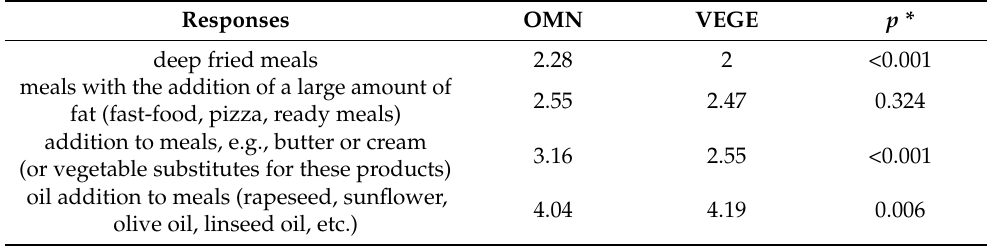
Table 8. Summary of the health state of the studied groups. Health State of the Studied Groups With risk factors for cardiovascular diseases (smoking regularly and/or medium/high alcohol consumption) With risk factors for cardiovascular diseases (dyslipidemias and/or dysfunction of carbohydrate metabolism) With cardiovascular